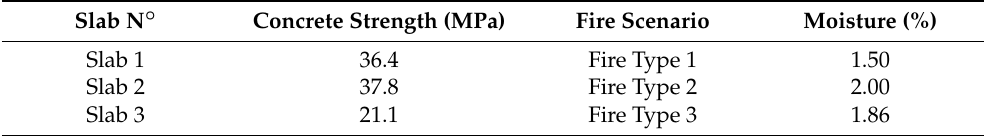
Figure 3. Fire scenarios validation model (Adapted with permission from Guo and Bailey [16]).